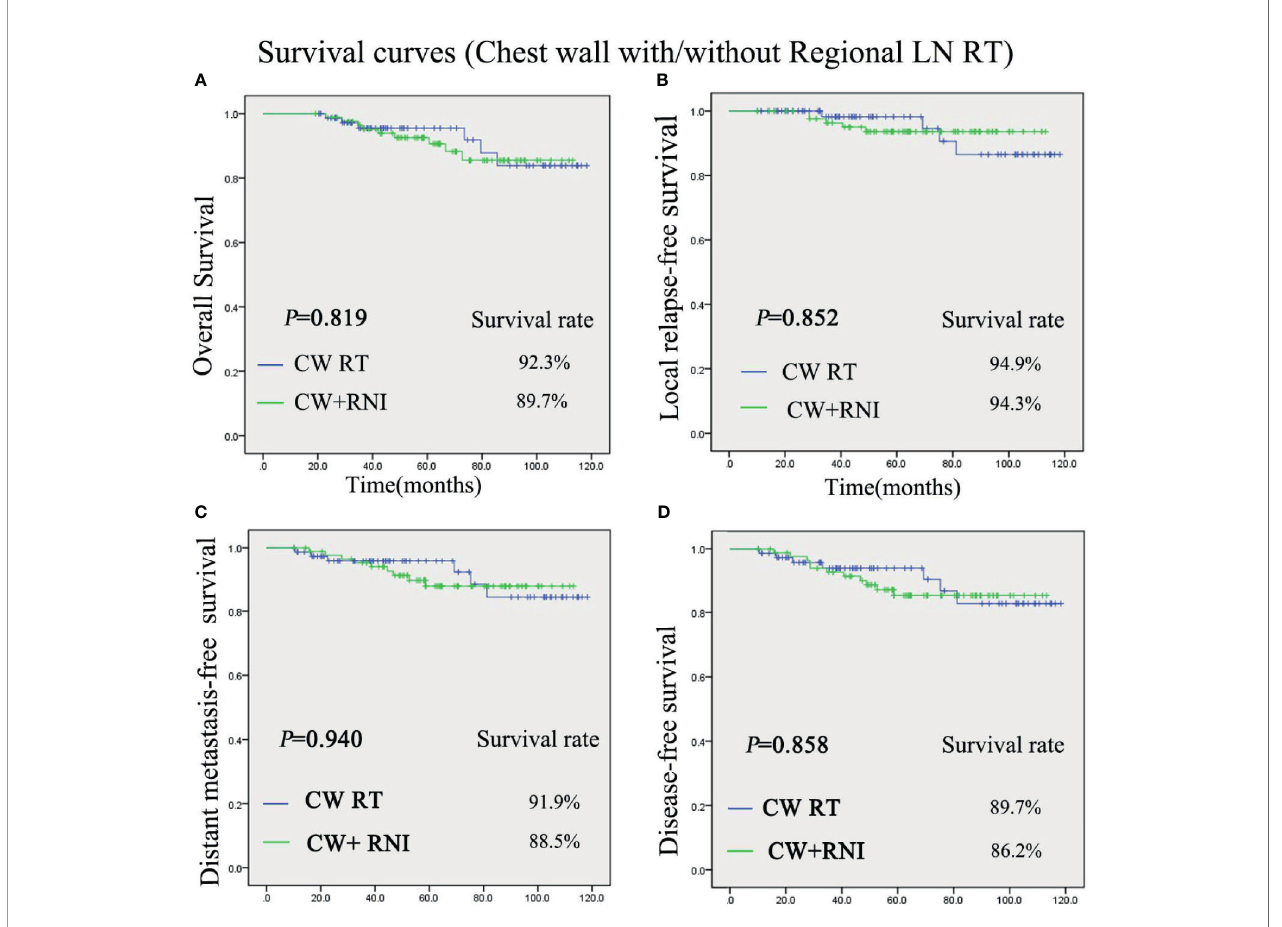
FIGURE 1 | Kaplan-Meier survival curves for chest wall radiation group and chest wall + regional lymph nodes radiation group. Overall survival (A) , disease-free survival (B) , local relapse-free survival (C) , and distant metastasis-free survival (D) . P values were calculated with the unadjusted log-rank test. CW, chest wall; RNI, regional lymph node